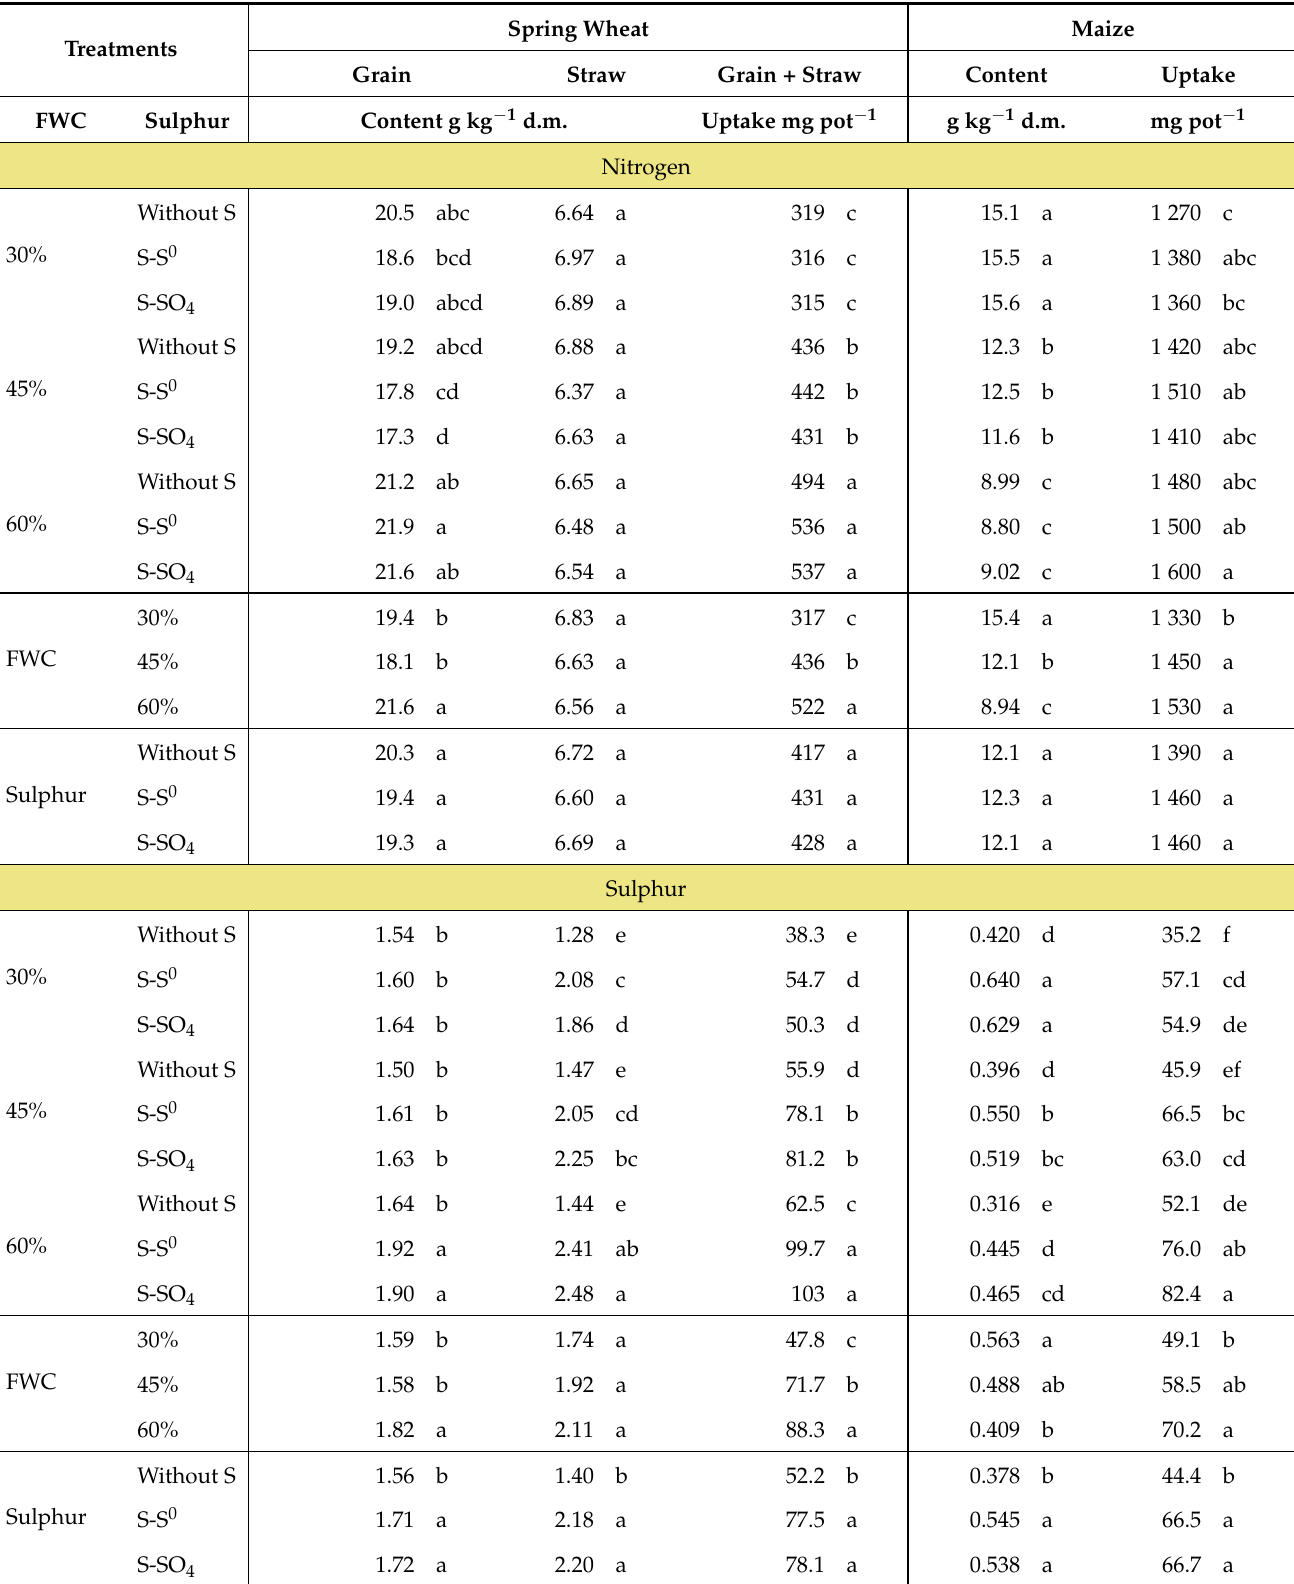
Table 3. Nitrogen and sulphur content and uptake in cultivated plants. Values indicated by the same letter are not significantly different ( α =